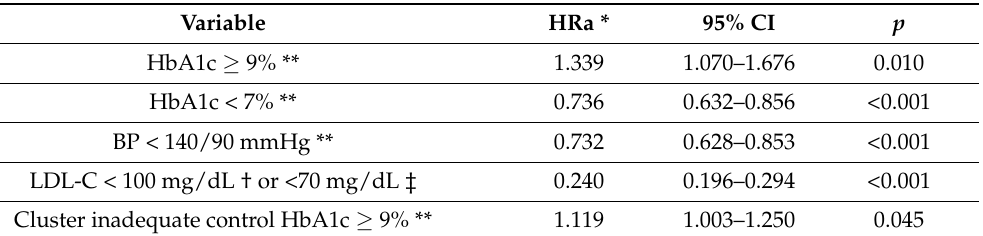
Table 1. Cox regression model to analyze the risk of admission for a CVE in patients with type 2 diabetes according to clusters of GPP HbA1c > 9% and individual levels of